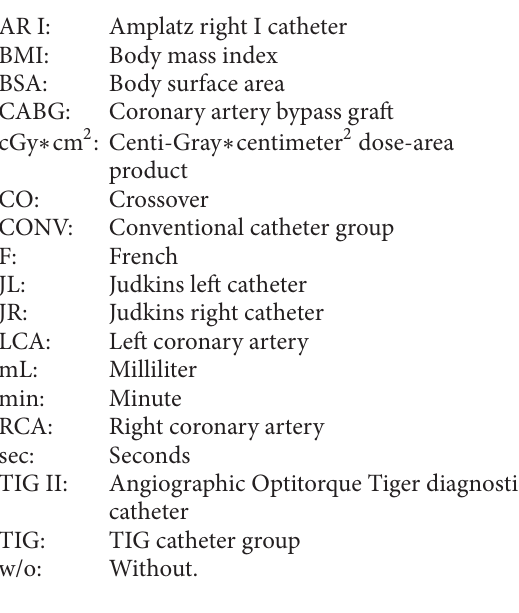
cGy ∗ cm 2 : Centi-Gray ∗ centimeter 2